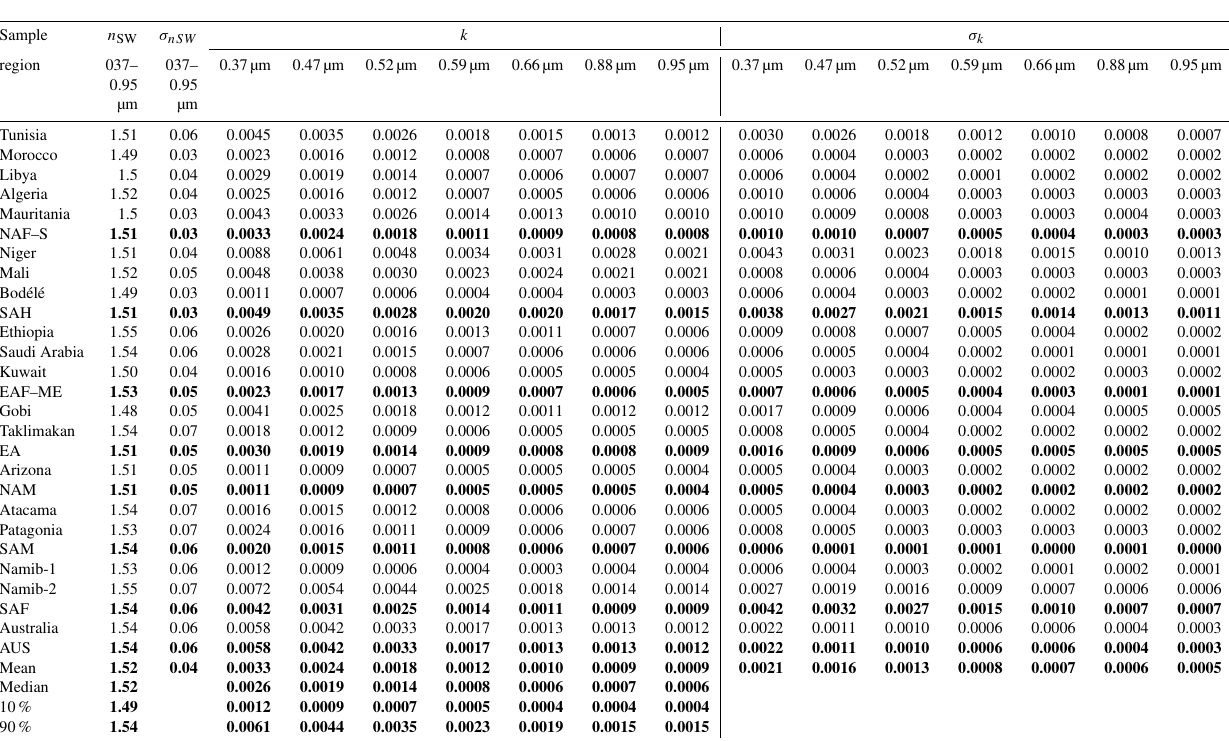
Table 4. Real ( n ) and imaginary ( k ) parts of the refractive index estimated for the 19 analyzed dust samples and mean values calculated for the eight regions and for the full dataset. Data for single soils are reported as experiment-averaged values, and their uncertainty is calculated as indicated in Table 1. Mean values and standard deviations (SDs) at each wavelength based on single-sample data are reported for the eight regions and the full dataset. The median and 10% and 90% percentile are also reported for the full dataset. For North America and Australia, for which only one dust sample was analyzed, the reported data correspond to the single sample available from these regions. For the real part, the average over the whole shortwave range ( n SW ) is indicated. Mean ( ± SD), median, and 10% and 90% values are indicated in